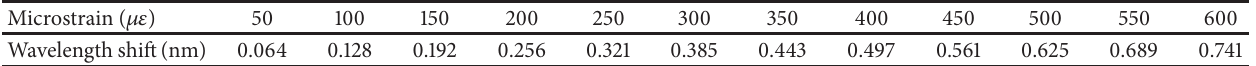
Table 1: Bragg wavelength shift versus the applied strain.